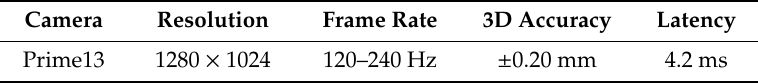
Table 3. The parameters of the cameras used in the experiment.